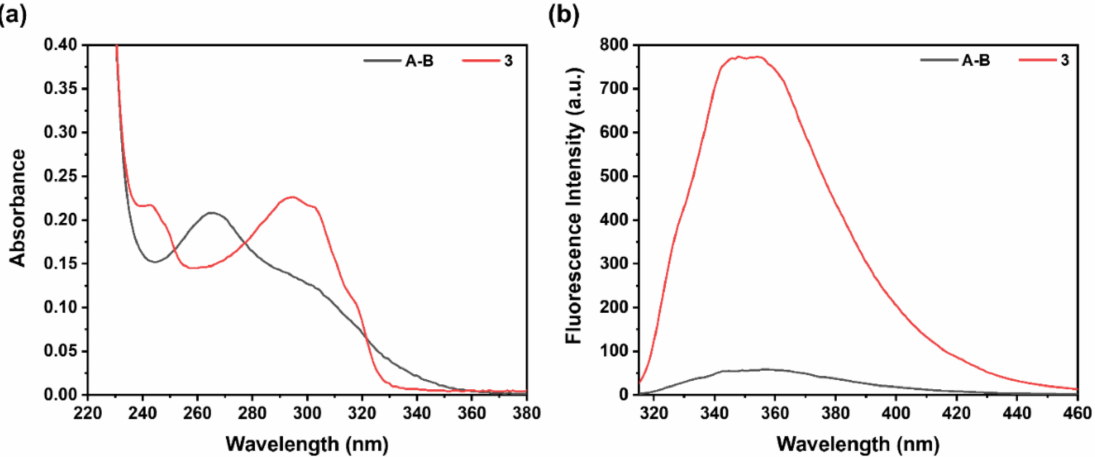
Figure 2. Characterization of compound 3 (10 µ M; λ ex = 303 nm, λ em = 350 nm) and A-B (10 µ M; λ ex = 265 nm, λ em = 357 nm) dissolved in 1 mM HEPES buffer solution containing 0.1% DMSO by ( a ) UV − Vis and ( b ) fluorescence emission spectra at room